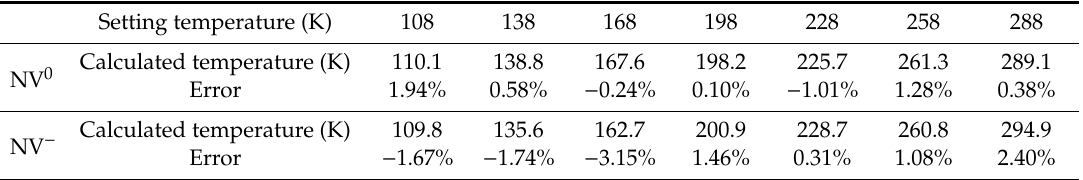
Figure 4. The accuracy determination of ( a ) NV 0 and ( b ) NV − centers in temperature measurement based on the energy level shifts. Table 2. A comparison of the accuracy between setting and calculated temperature of NV centers based on the modified Varshni